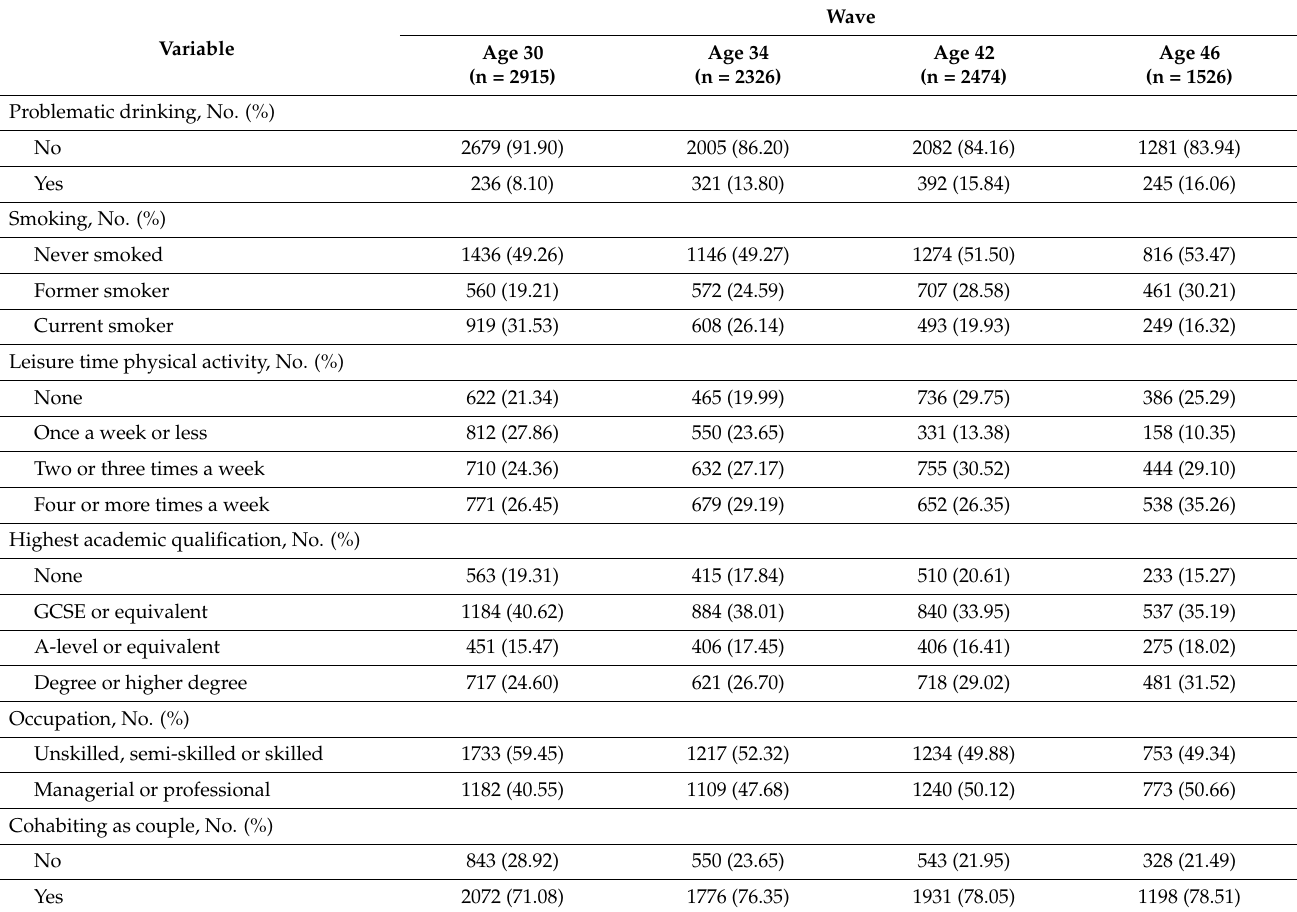
Table 2. Female participants’